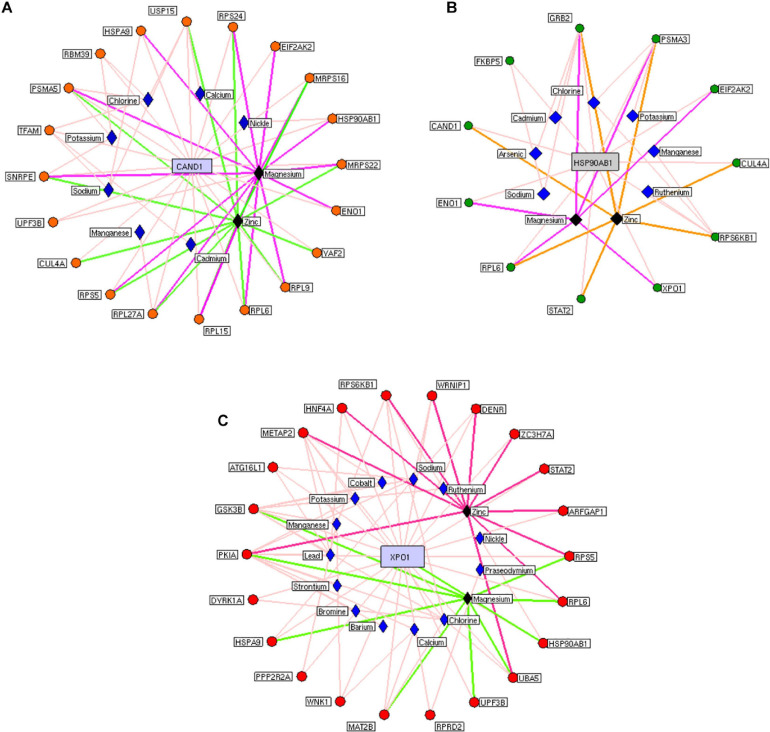
Highly interactive metalloprotein hubs: Three highly interconnected protein hubs (A–C) extracted from the metalloprotein network. Colored circular nodes represent metalloproteins connecting to the core protein (blue rectangular box). The edges (colored line) between the proteins and their cofactor metals (violet rhombus). Black rhombus representing the cofactors that bound with more metalloproteins in the hubs.